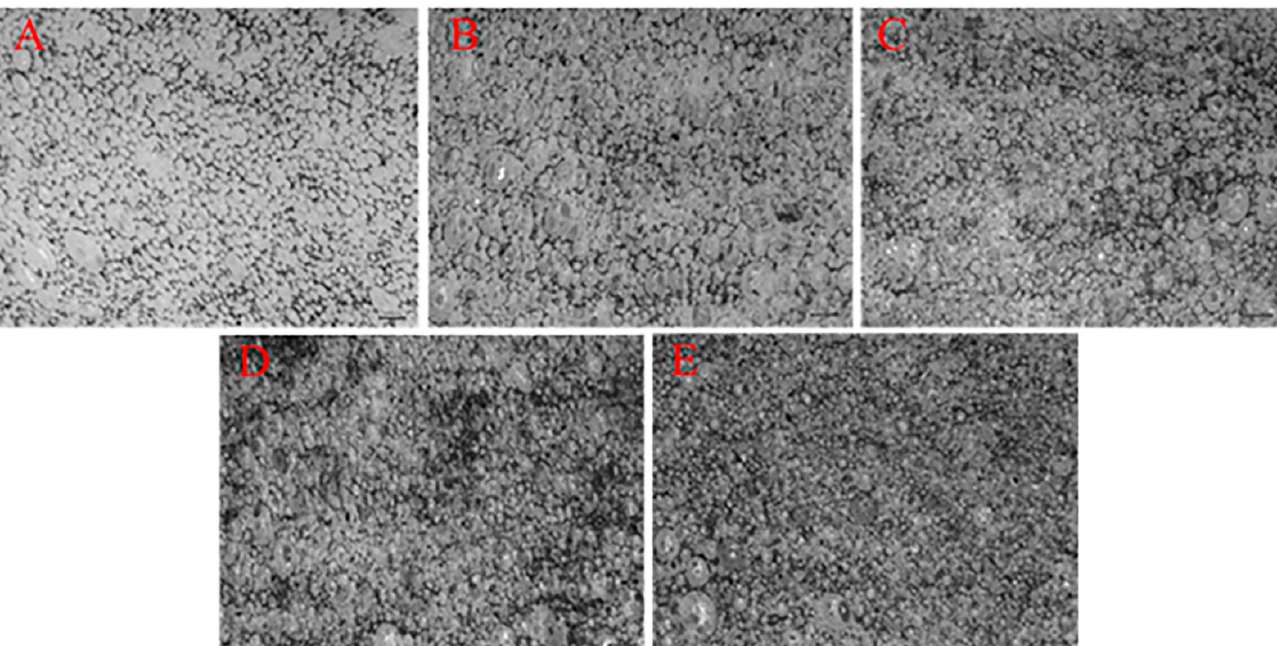
Figure 3. Stereomicroscopic images (magnified by 10 × 0.67) of ( A ) HCMF0, ( B ) HCMF5, ( C ) HCMF10, ( D ) HCMF15, and ( E ) HCMF20.